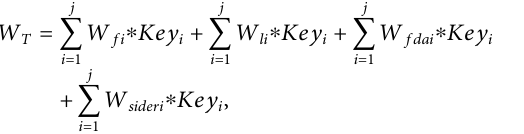
Algorithm 2. Customized NLP Model to Extract Tokens From